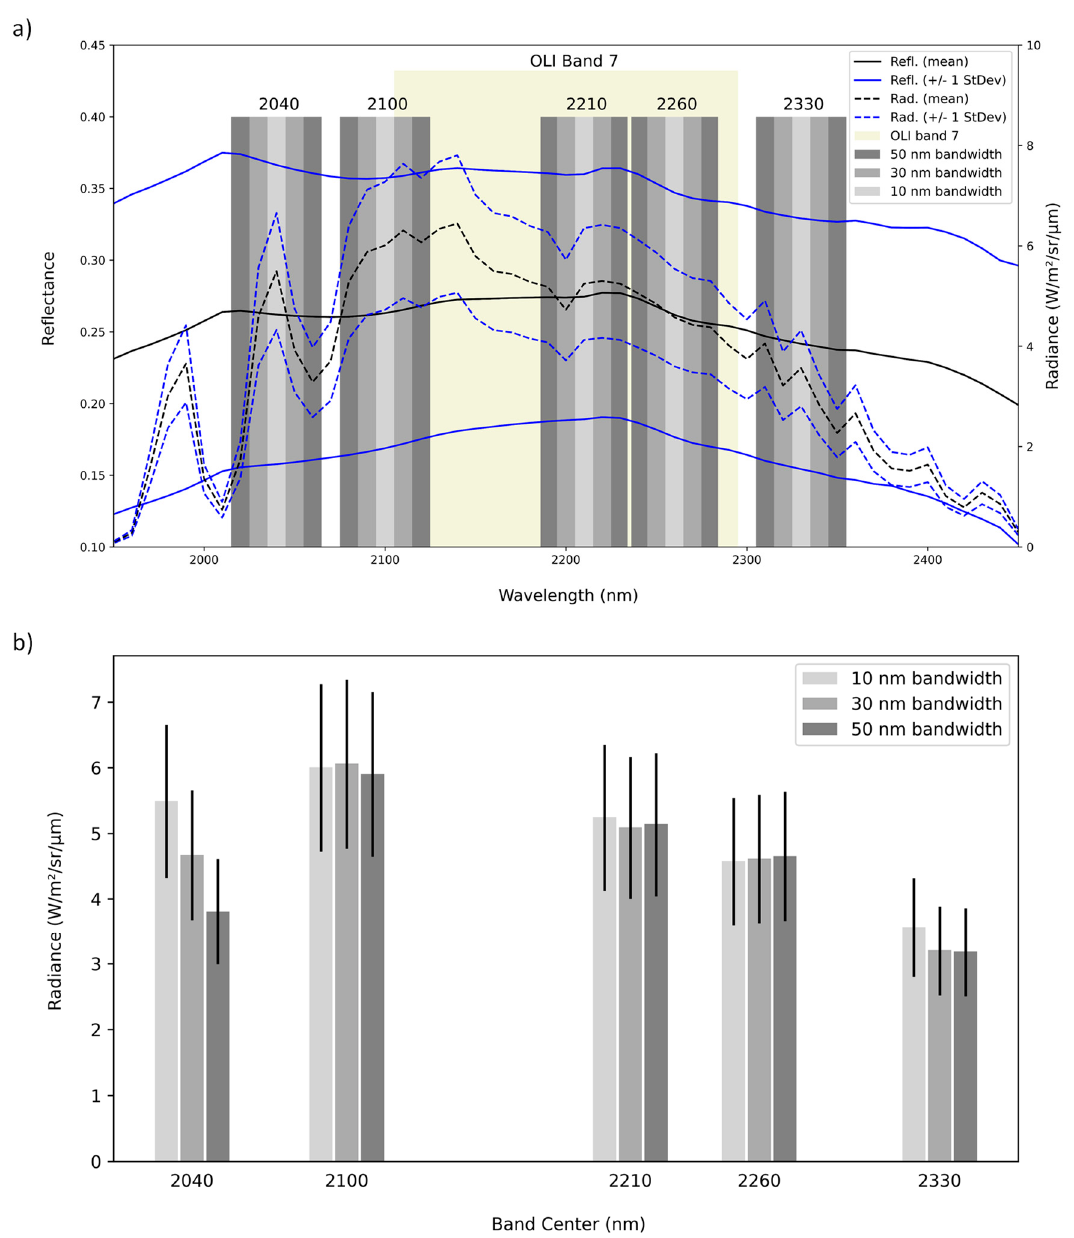
Figure 5. ( a ) MODTRAN input mean surface reflectance spectra (Refl., solid lines) and output mean at-sensor radiance spectra (Rad., dashed lines), plotted with the five considered Landsat Next bands at various bandwidths. ( b ) MODTRAN mean at-sensor radiance spectra averaged by bandwidths of 10, 30, or 50 nm for the considered Landsat Next bands. The 2040 nm band is increasingly impacted by atmospheric CO 2 absorption at wider bandwidths.